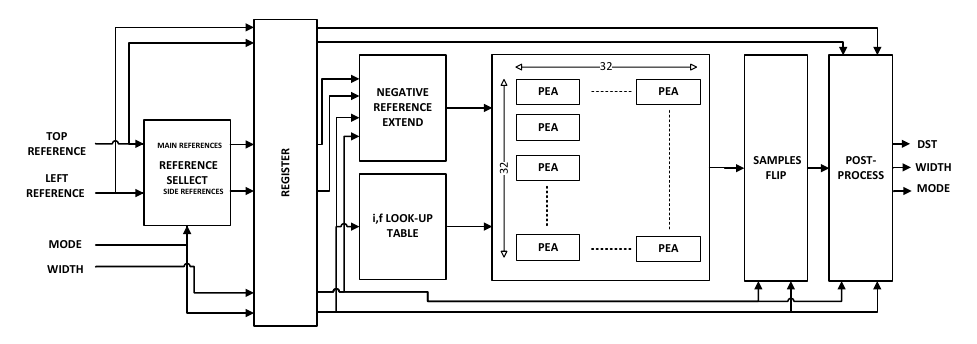
Figure 8. The proposed hardware architecture for H.265/HEVC intra Angular mode.